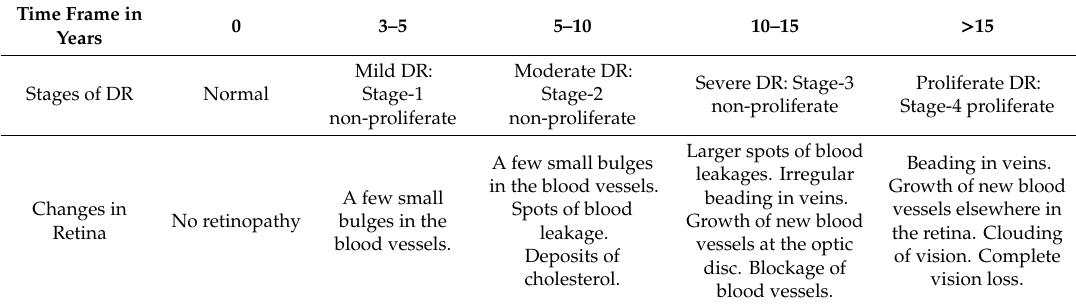
Table 1. Various stages of diabetic retinopathy